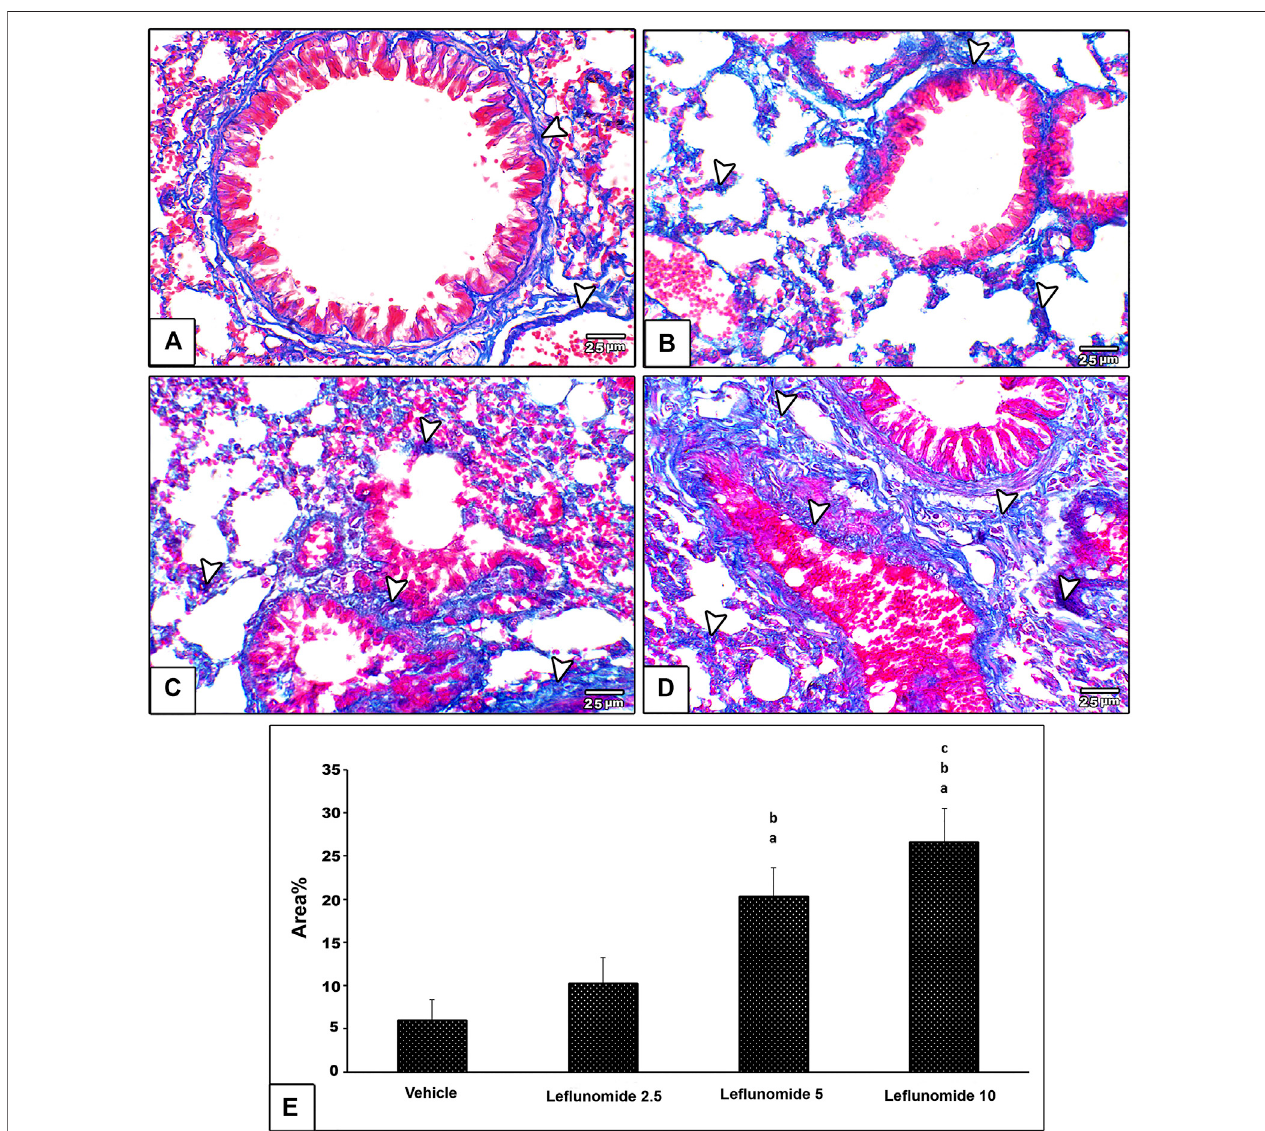
FIGURE 6 | Photomicrograph of Masson ’ s trichrome stained lung sections (A) An image from the vehicle control group shows minimal amount of collagen fi bers (blue color) (arrow head) in pulmonary interstitium surrounding blood vessels and bronchioles (B) An image from group ii shows mild amount of fi brosis in pulmonary interstitium,perivascularandperibronchiolarareas (C) Animagefromgroupiiishowsmoderateincreasedcollagendeposition (D) Animagefromgroupivshowsmarked depositionofcollagen fi bersinlungsection (E) Acolumnchartrepresentingthemeanarea ± SDM, (A) :vs.thevehiclegroup, (B) :vs.thele fl unomide2.5 mgperkg group, (C) : vs. the le fl unomide 5 mg per kg group at p <